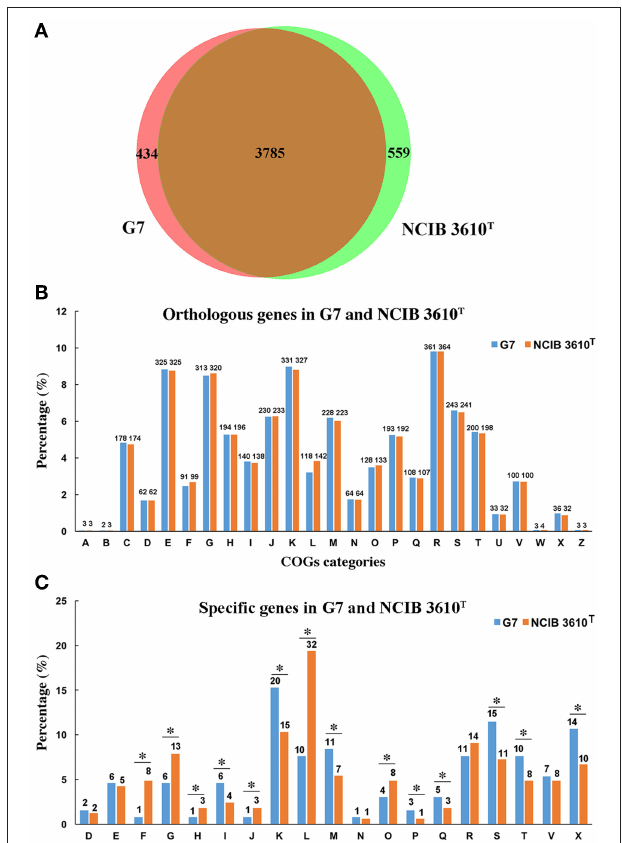
FIGURE 4 | Comparison of the gene content of G7 and NCIB 3610 T . (A) A Venn diagram of the orthologous and specific genes in G7 and NCIB 3610 T . (B) Orthologous genes assigned to COG categories in each strain. (C) Specific genes assigned to COG categories in each strain. The alphabetic codes represent COG functional categories as shown in Figure 2 . Asterisks indicate differences of more than